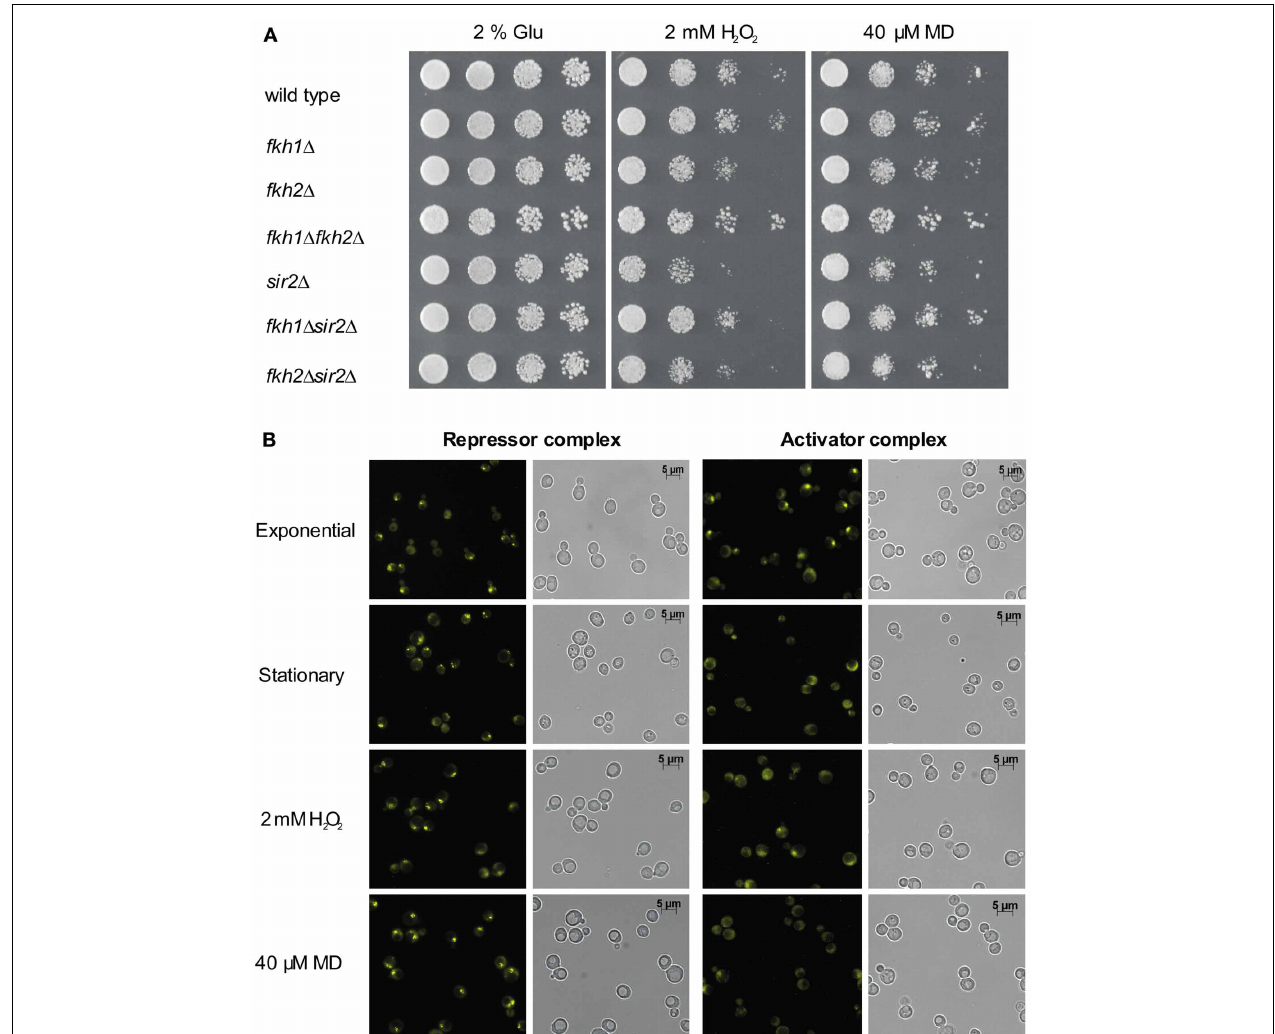
representative experiment is shown. (B) BiFC analysis. Haploid cells expressing Sir2-VC or Ndd1-VC were transformed with plasmid p426GPD-VN-Fkh1or p426GPD-VN-Fkh2,respectively. Subsequently, yeast cells were analyzed for BiFC signals in exponential phase (OD 600 ∼ 0 . 6), in stationary phase (OD 600 ∼ 1 . 6) and in the presence of 2mM H 2 O 2 or 40 μ M